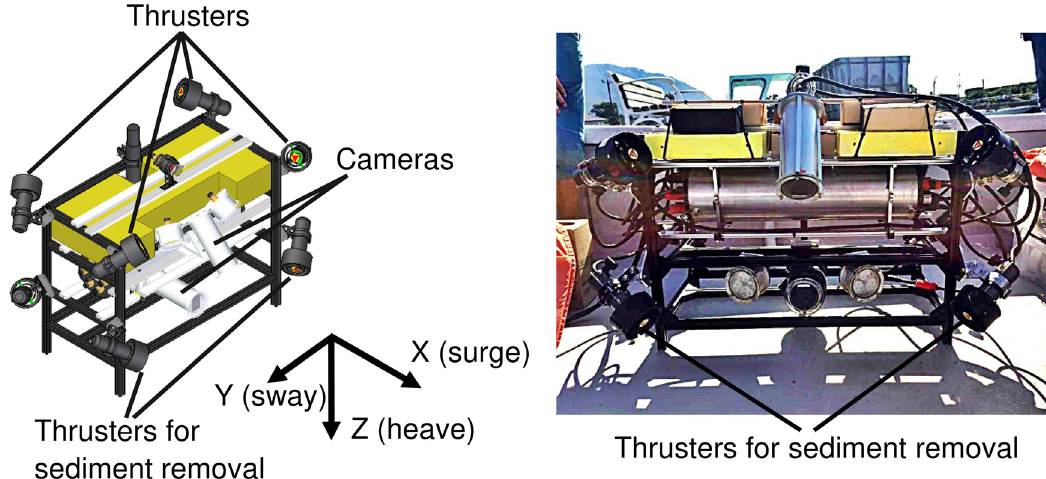
Fig. 13 CAD and the developed